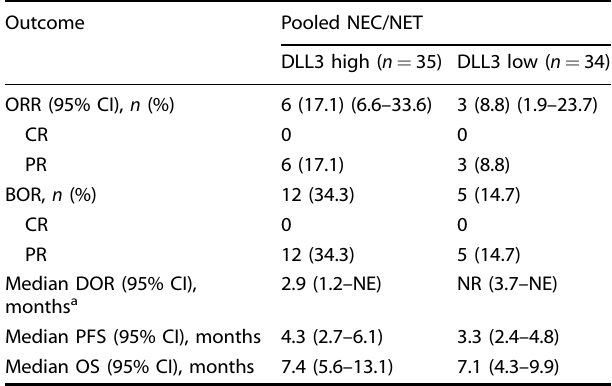
Table 5. Ef fi cacy for DLL3-high and DLL3-low expression in Pooled NEC/NET at the 0.3-mg/kg